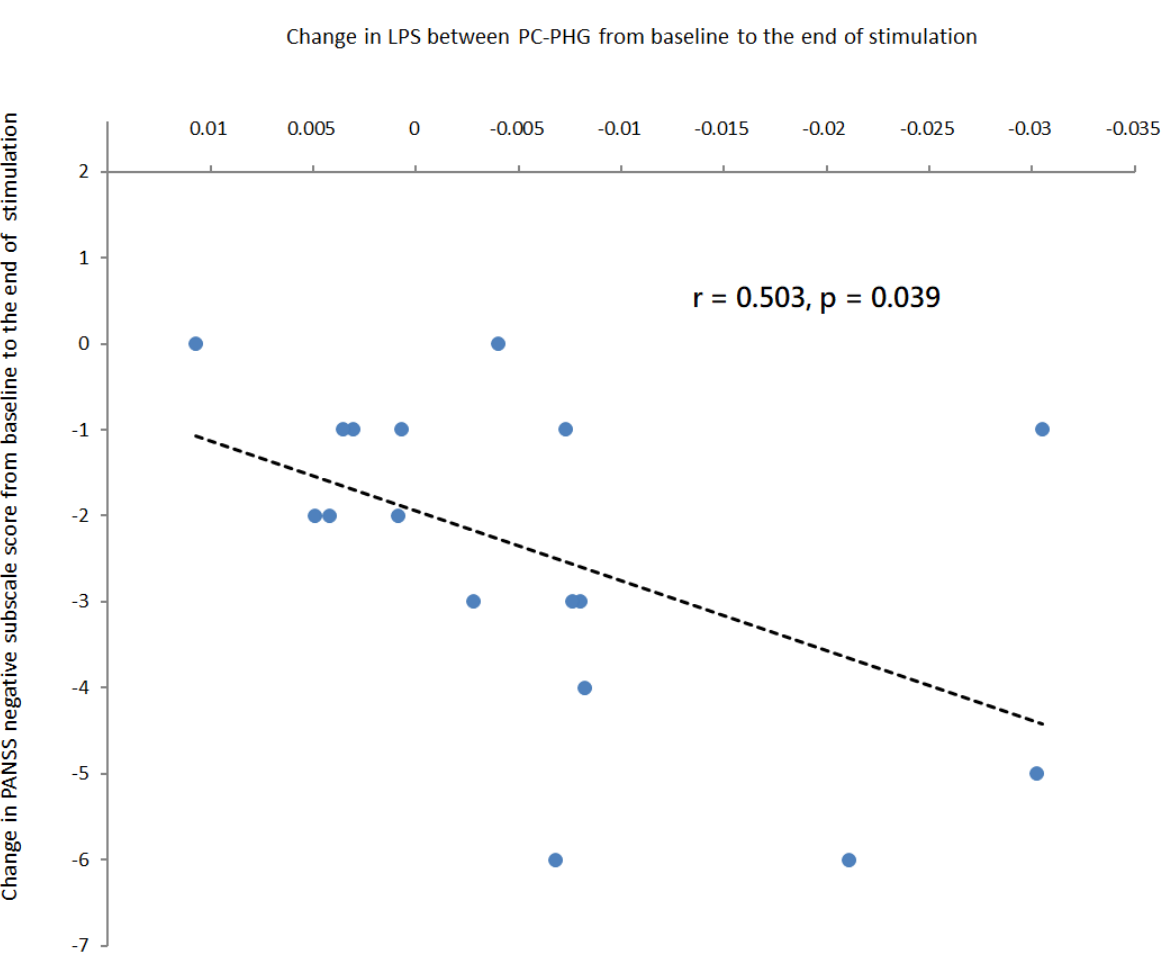
Figure 5. Correlation analyses in patients treated with active online theta-tACS showed that a greater reduction in the LPS between the posterior cingulate and the parahippocampal gyrus from baseline to the end of stimulation was associated with a greater reduction in PANSS negative subscale score from baseline to the end of stimulation. The regression line for the linear regression slope was shown.